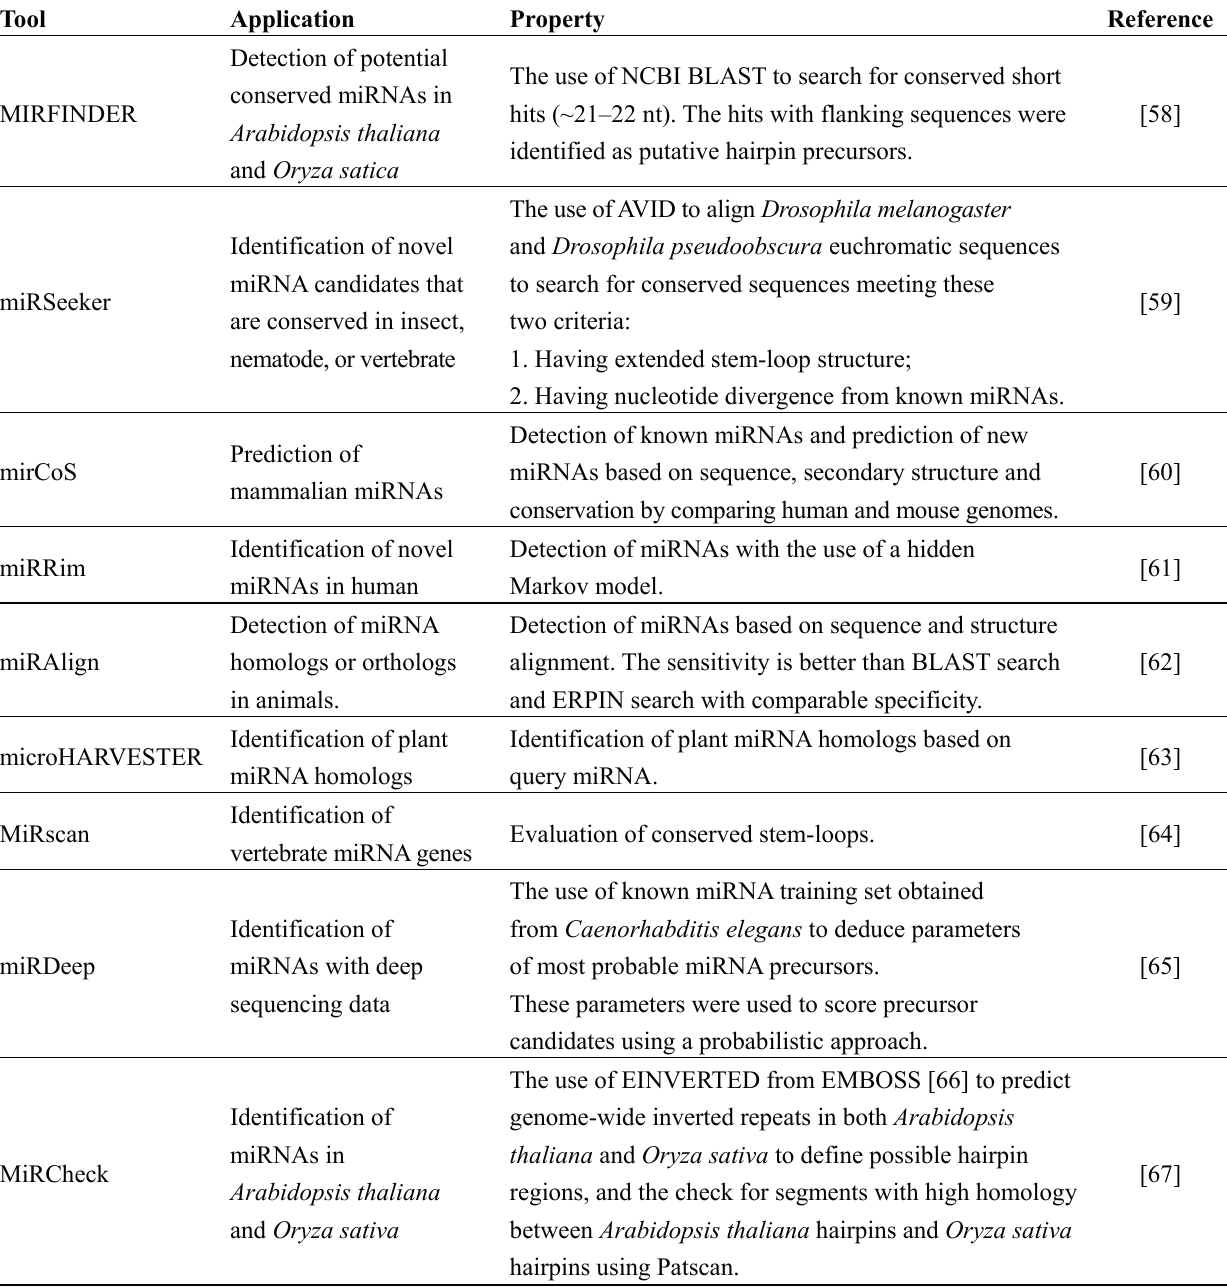
Table 2. Summary of classical miRNA prediction